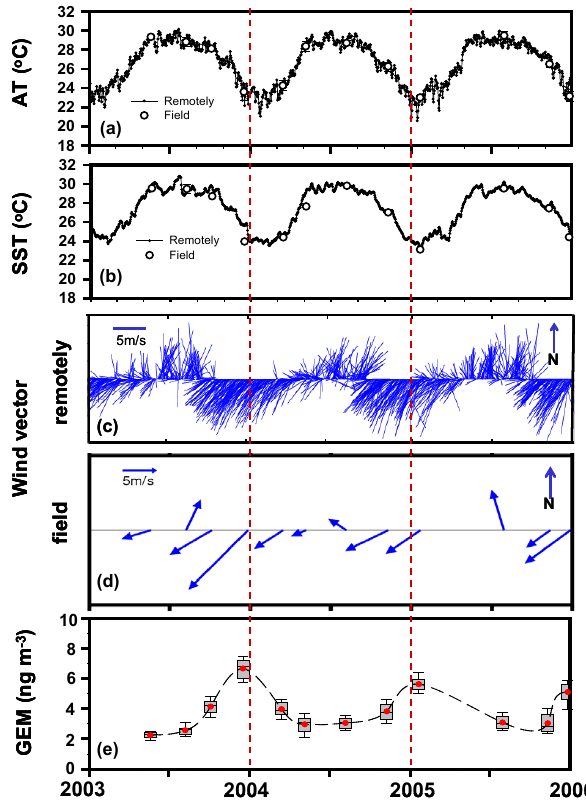
Fig. 2. Time-series of records obtained for the SEATS station over northern South China Sea during the study period from Aug. 2003 to Dec. 2005. (a) Remotely sensed surface air temperature (AT • and field observed, ◦ ) ; (b) Remotely sensed sea surface temperature (SST • and field observed, ◦ ); (c) remotely sensed wind vector and speed (WS); (d) field observed wind data; (e) averaged GEM. Boxes represent interquartile ranges, bars delineate upper and lower 10%, and the center line is the median; means are shown by red •